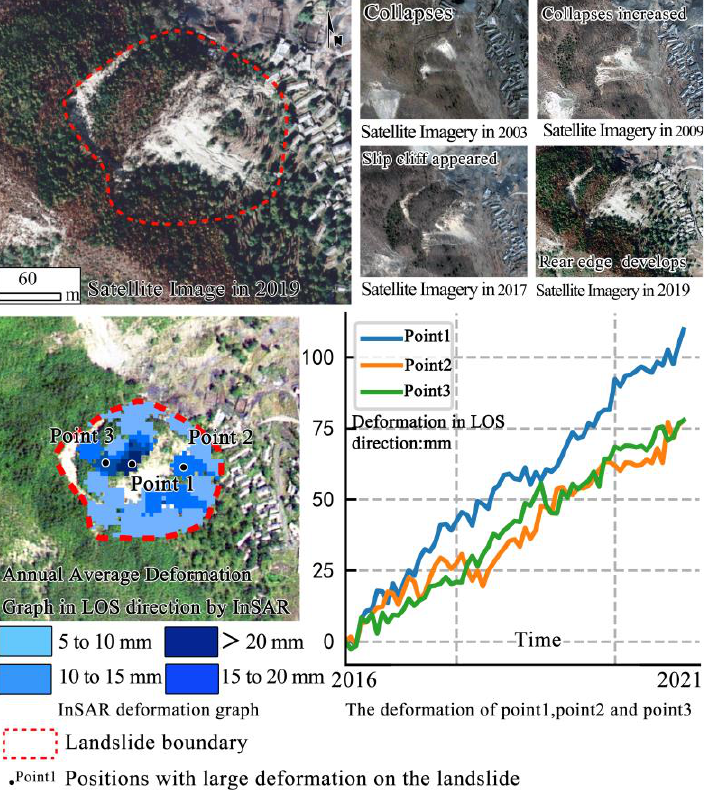
Figure 7. Optical images of landslide S06 acquired in 2003, 2009, 2017 and 2019 (the upper five panels). Deformation velocity of landslide S06 got by InSAR (left lower panel). The deformation in LOS direction of the three points during 2016 – 2021 are shown in the right lower panel.